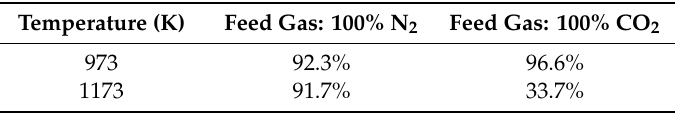
Table 4. Char residual mass (as percentage of initial mass) after thermal degradation tests in pure N 2 and in pure CO 2 , at 973 and 1173